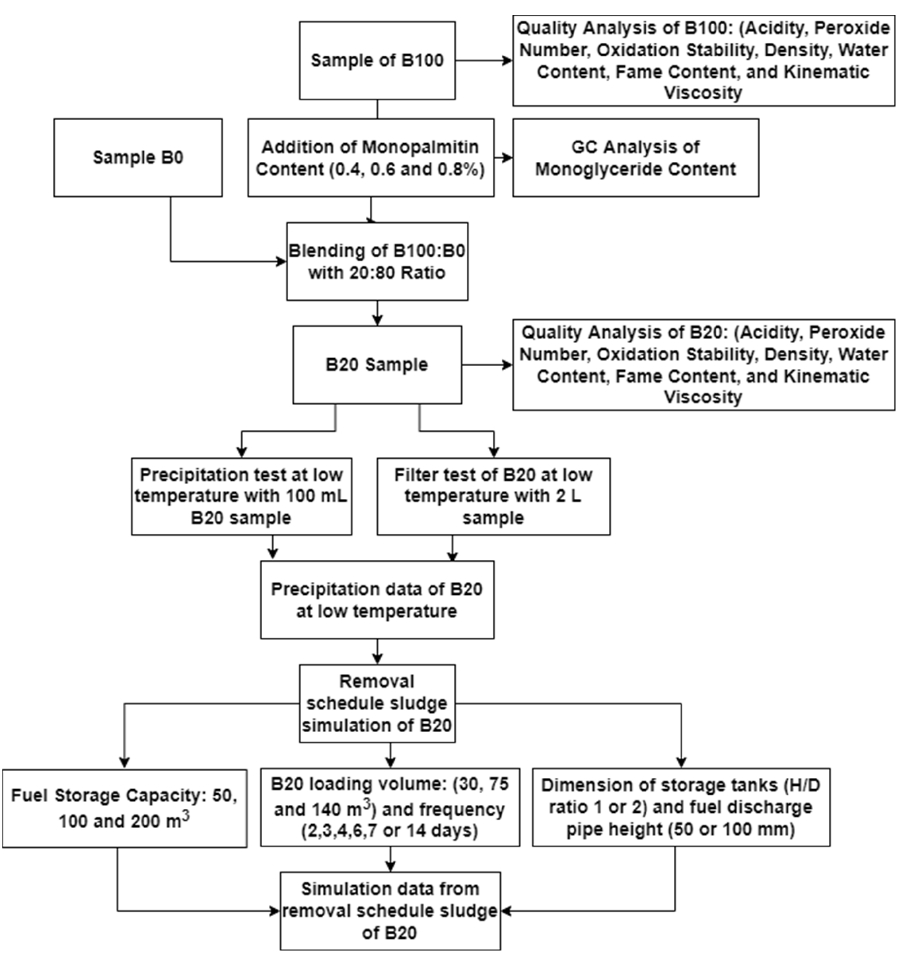
Figure 2. Flowchart for the precipitation tests for sludge removal prediction in the B20 storage tank.